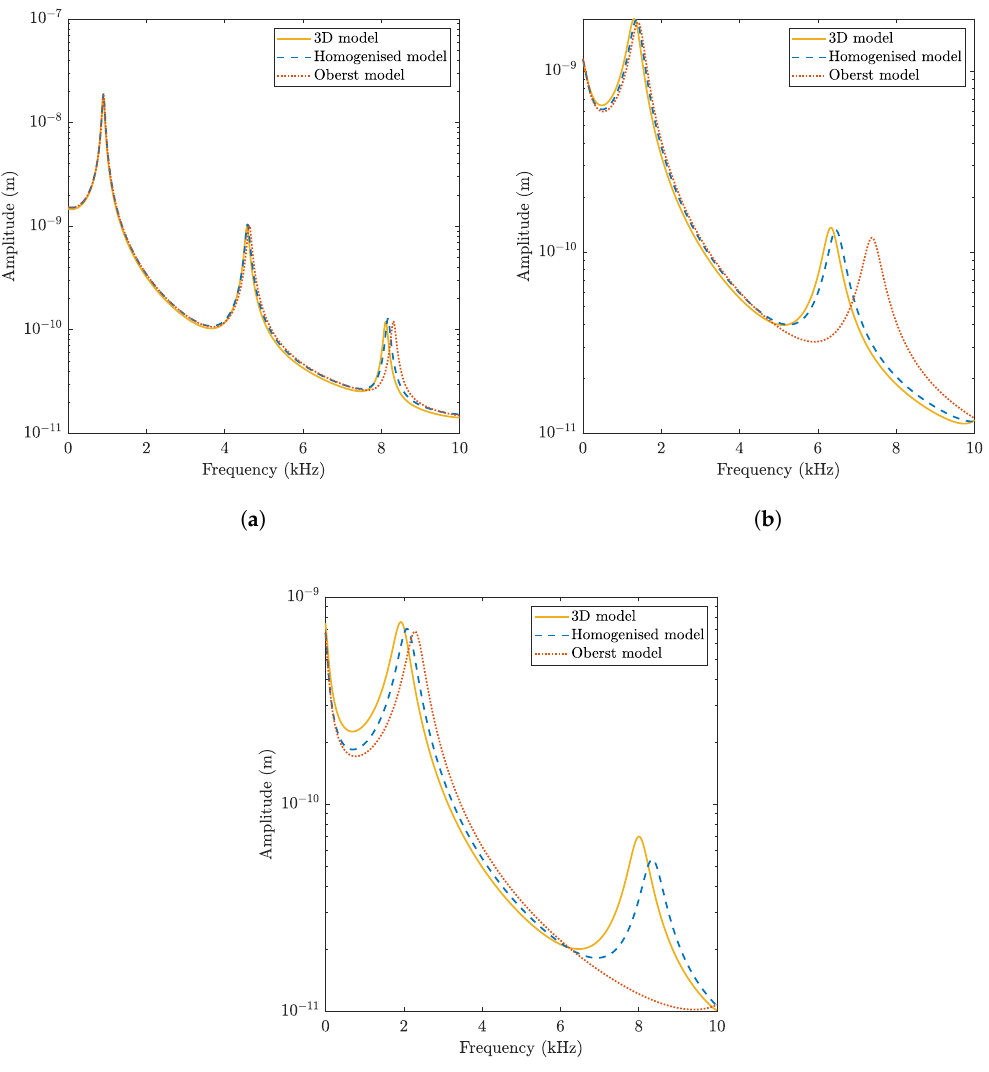
Figure 5. Amplitude of the transverse displacement of the simply supported FLD plate when subjected to a unit pressure: ( a ) H 2 = 2 mm; ( b ) H 2 = 6 mm; ( c ) H 2 = 10